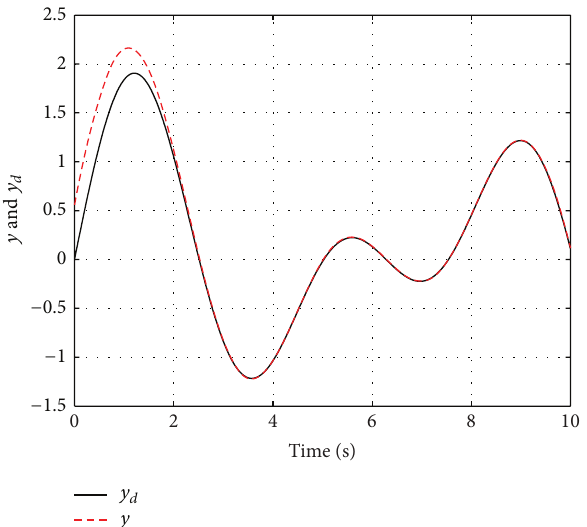
Figure 8: System output 𝑦 on 𝑦 𝑑 (𝑘 = 10) in Case 2.